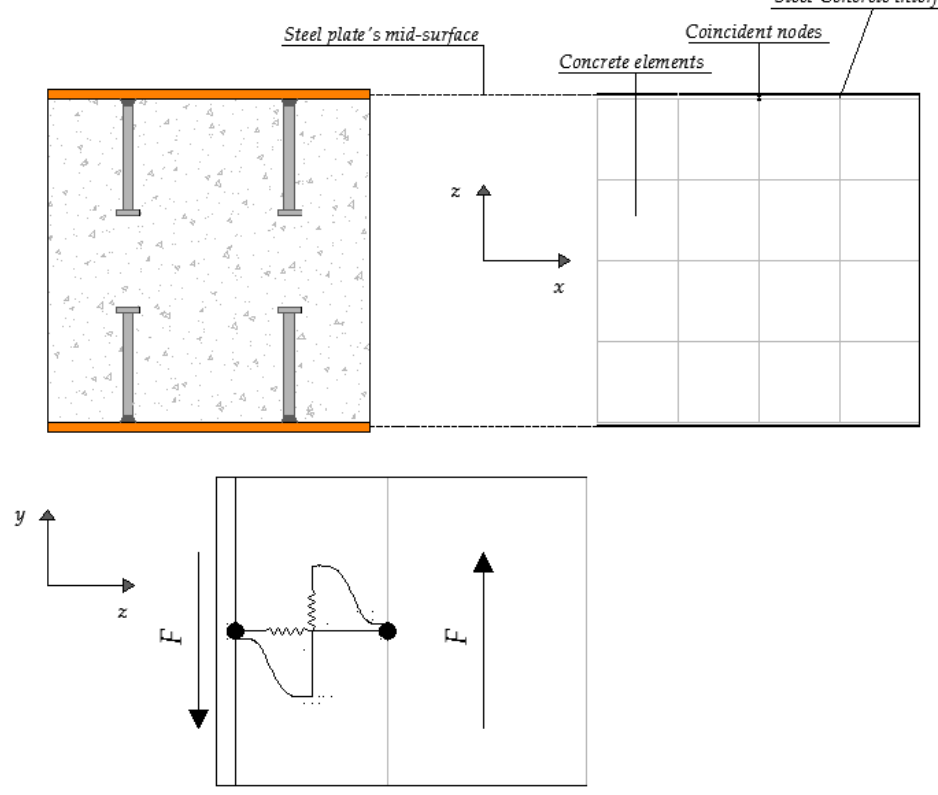
Figure 7. Finite element modelling of shear connectors.